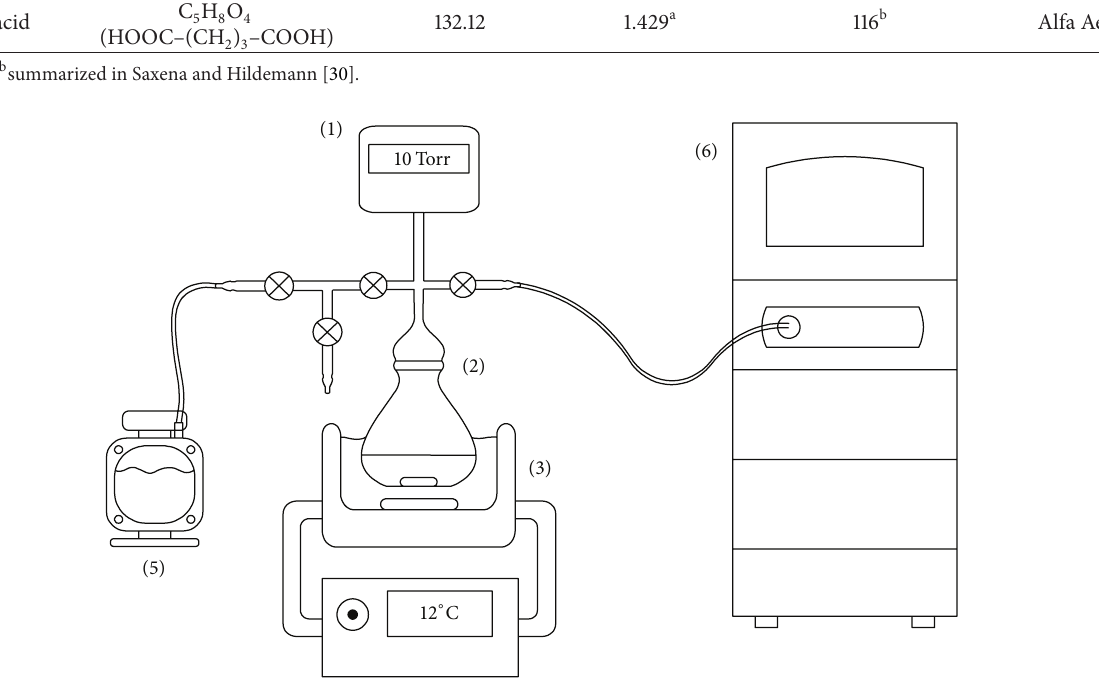
Figure 1: Schematic of water uptake measurement apparatus. This drawing shows the interconnections between (1) Baratron pressure transducer, (2) glass vessel manifold, (3) thermostat bath, (4) refrigerated circulator, (5) high vacuum pump, and (6) quadrupole mass spectrometer